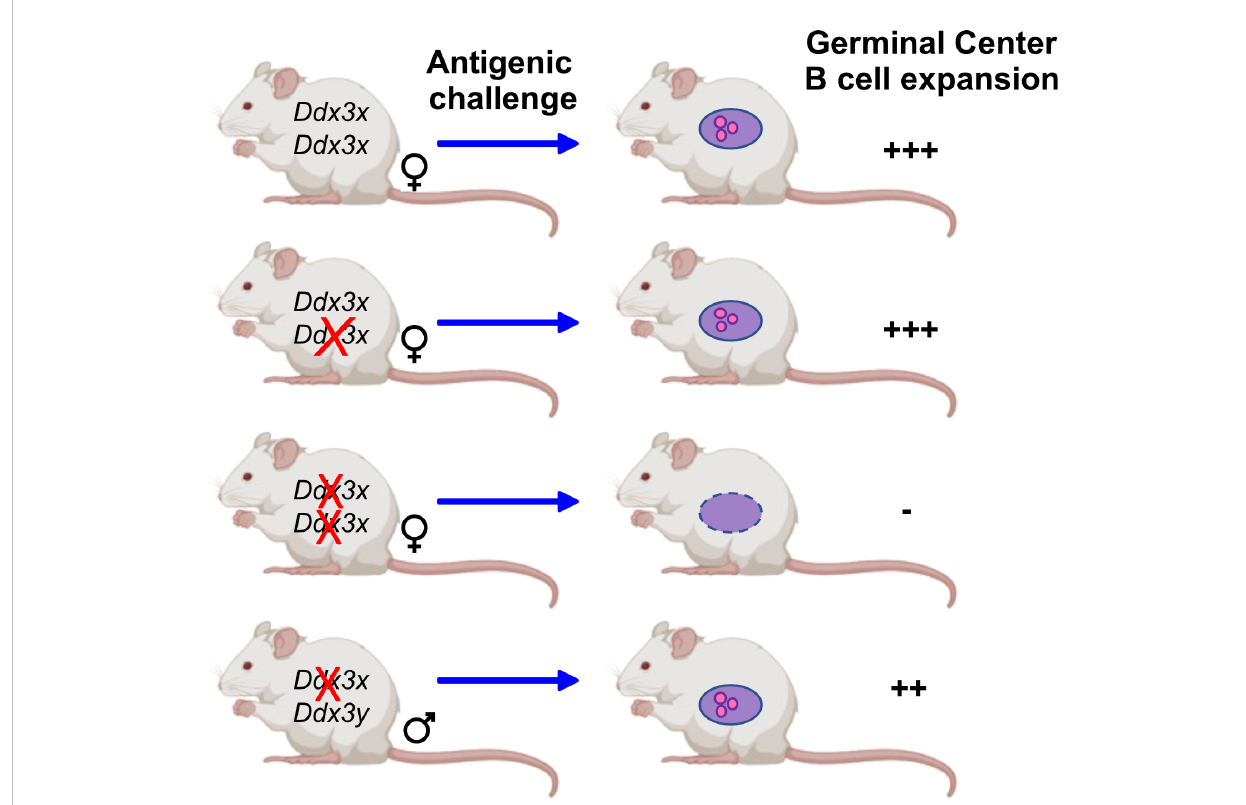
FIGURE 3 DDX3 activity is required for GC B cells. Mice that carry conditional Ddx3x alleles deleted by C g 1 -cre upon antigenic challenge show a sex speci fi c reaction: The deletion of one Ddx3x allele is well tolerated by female mice and antigenic challenge leads to the expansion of germinal center B cells to the same extent as in wt mice that carry both Ddx3x alleles. When both Ddx3x alleles are deleted using the C g 1 -cre deleter, an antigenic stimulus does no longer elicit the expansion of germinal center B cells. In male mice lacking Ddx3x but not Ddx3y the development and expansion of germinal center B cells is still possible, but at a lower level compared to wt animals, indicating that DDX3Y can replace DDX3X albeit not as ef fi ciently